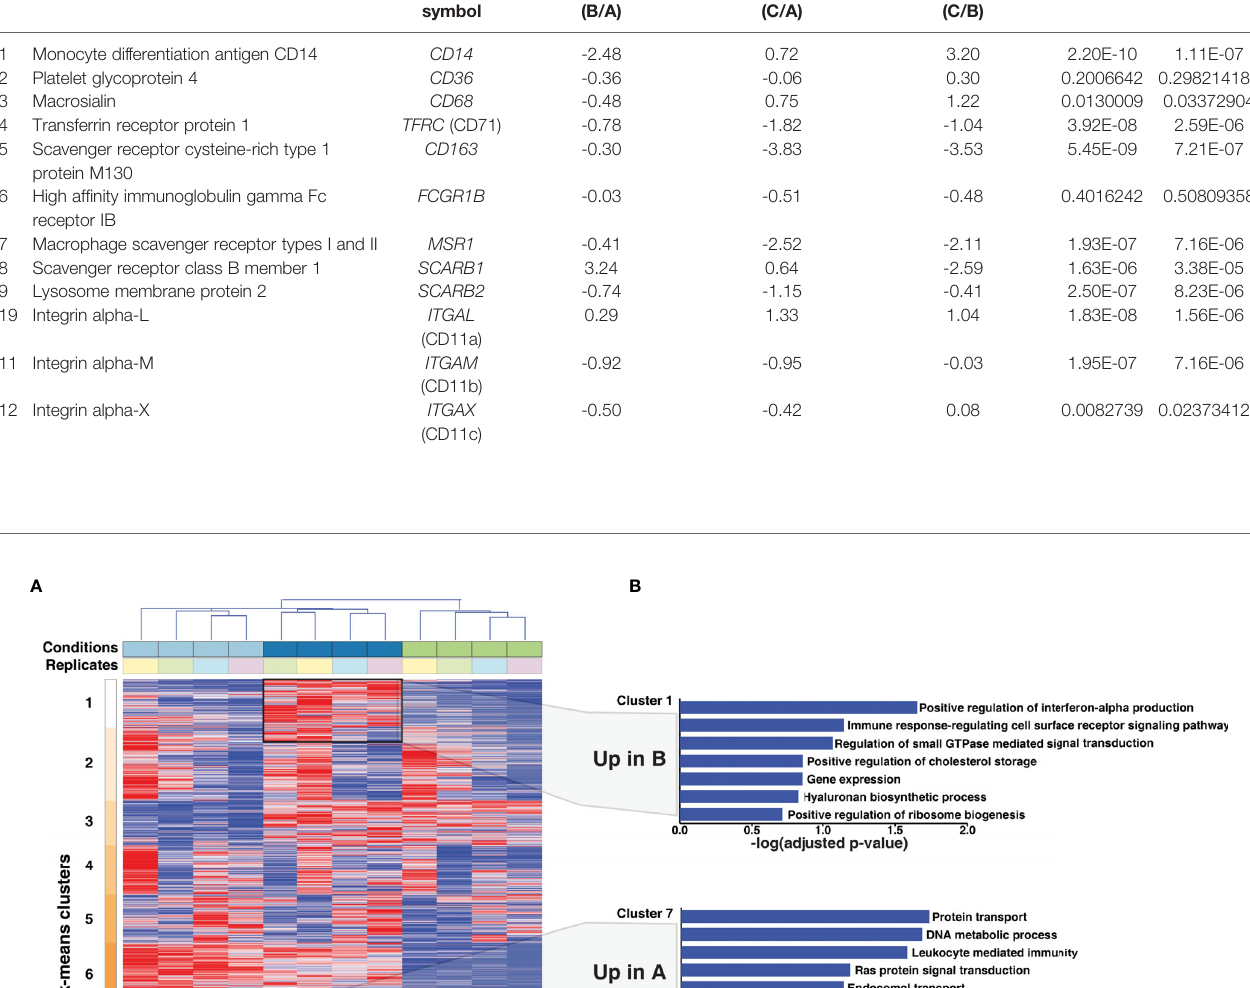
TABLE 1 | Expression pro fi le of monocyte-macrophage differentiation markers identi fi ed in this study. Protein description